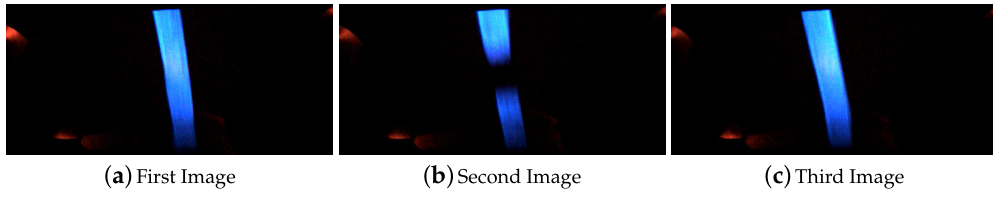
Figure 11. Sequence of images for the line occlusion for 10 cm inside a